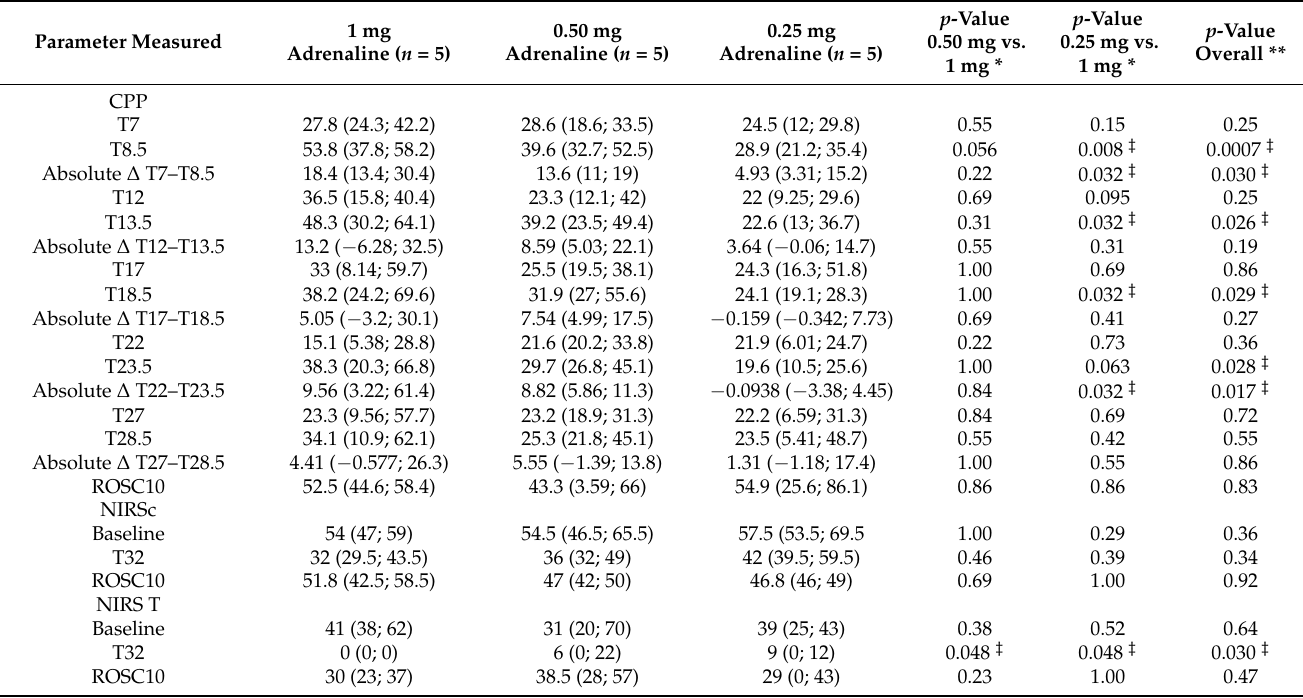
Table 2. Variation in CPP before and 90 s after injection for each randomization group, cerebral and tissular NIRS results.